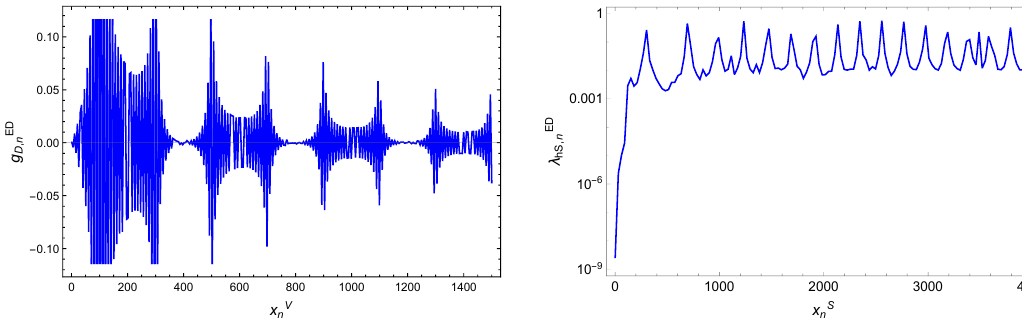
, for (cid:14) B (cid:11) = 10 TeV, while the n